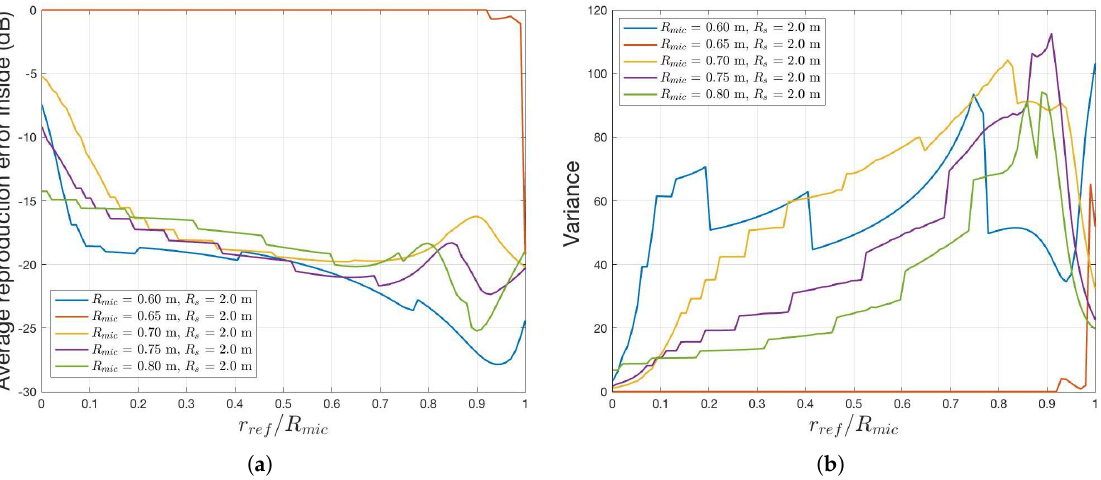
Figure 3. Wave field reproduction error and variances with respect to r ref . ( a ) Average wave field reproduction error. ( b ) Variance.